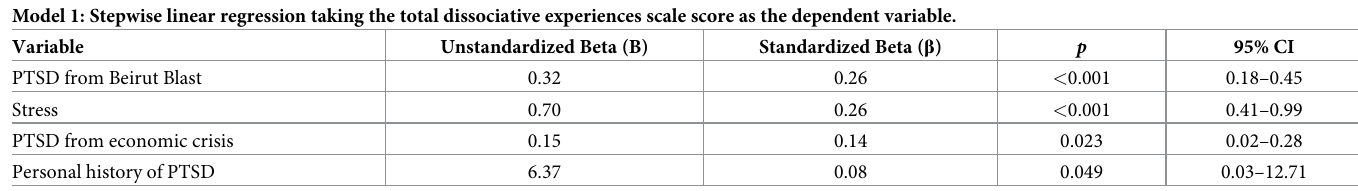
Table 5. Multivariable analyses. Model 1: Stepwise linear regression taking the total dissociative experiences scale score as the dependent variable.